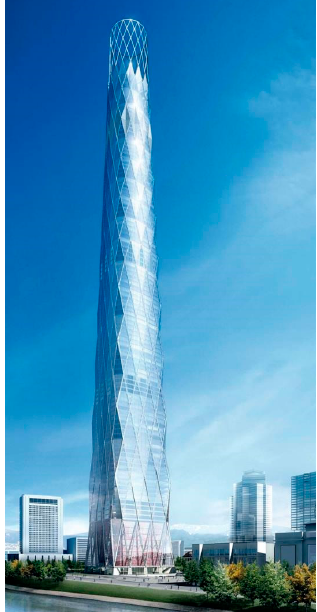
Figure 9. Lotte Super Tower, unbuilt (© SOM).